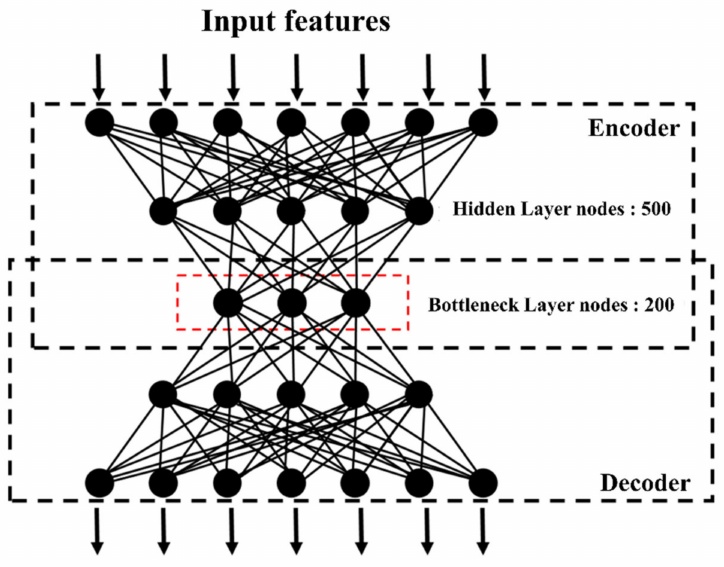
Figure 3. Architecture of the autoencoder model we adopted in this study.